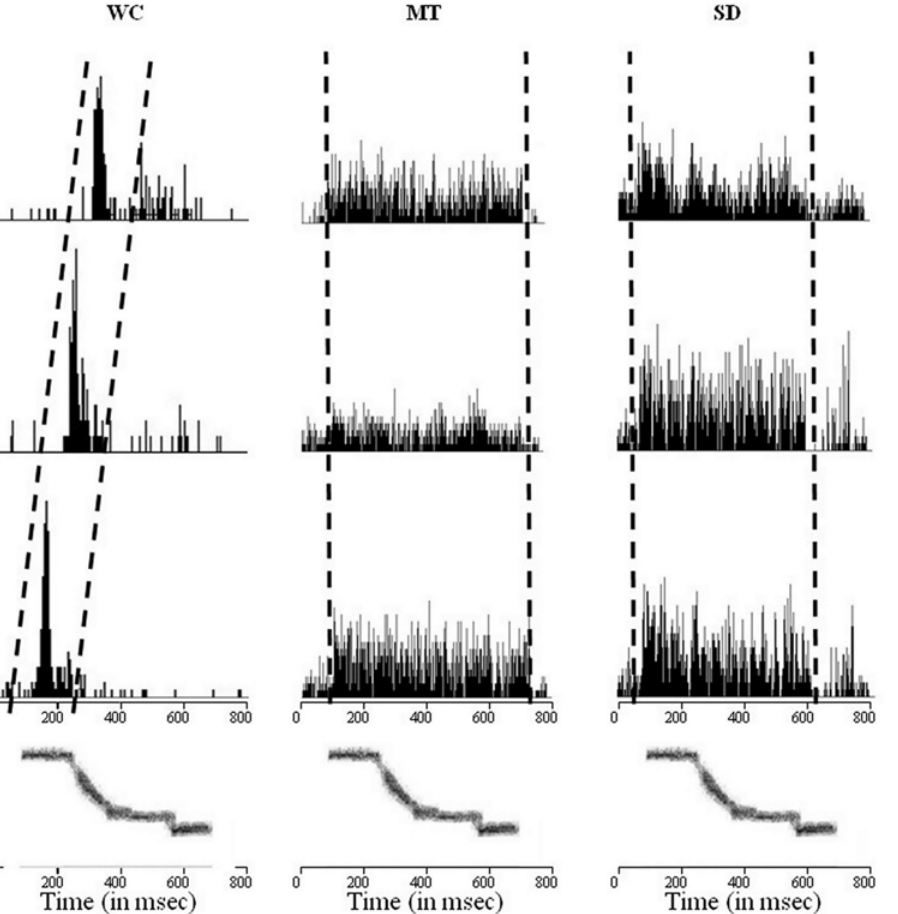
Figure 2. Examples of PSTHs calculated from three consecutive recording sites along a single penetration in a wild-caught (WC), a male-tutored (MT) and a socially-deprived (SD) Female. This example shows a pattern of selective responses at precise parameters typical of wild-caught birds: neurons responded to a restricted range of frequencies, shifting as frequency changed. While in male-tutored and socially- deprived birds, neurons were activated during the entire duration of the stimulus. The sonogram of the whistle used as stimulus is shown below the PSTHs.